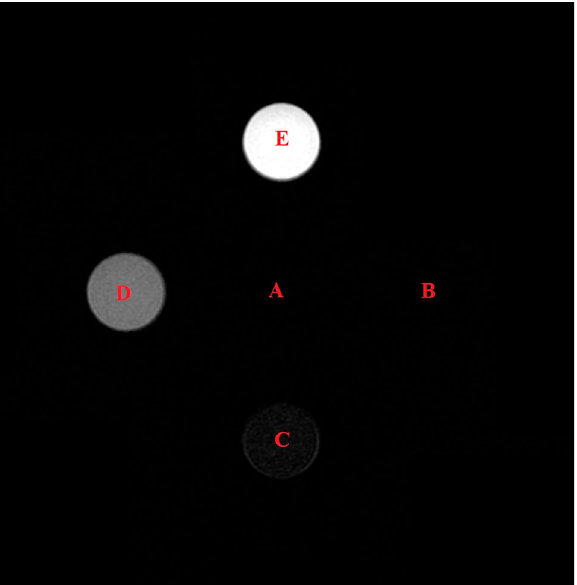
Figure 1. Magnetic resonance imaging evaluation (SSFSE TE: 1200 ms; TR 4000 ms) of five pure solutions with different Mn 2+ concentrations.